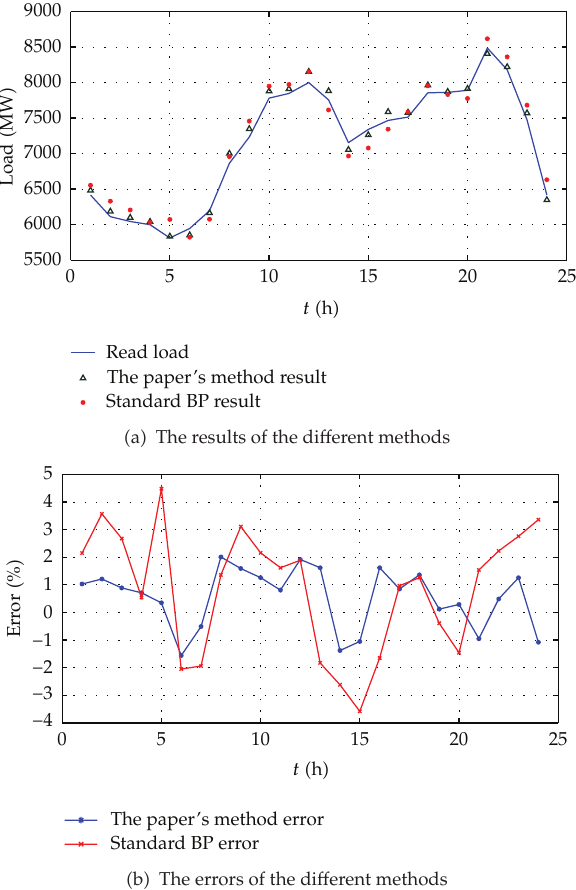
Figure 6: The di ff erent methods forecasting